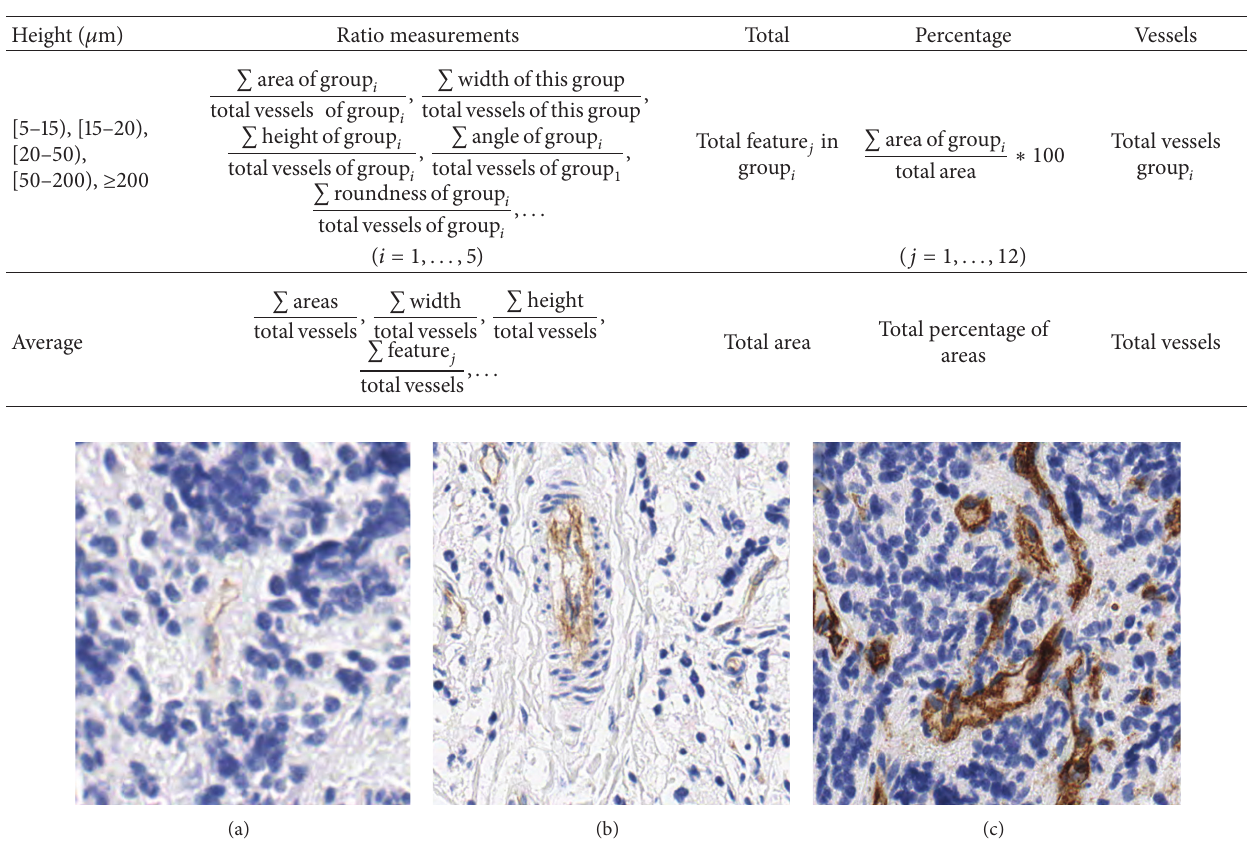
Table 2: Summary of measurements.